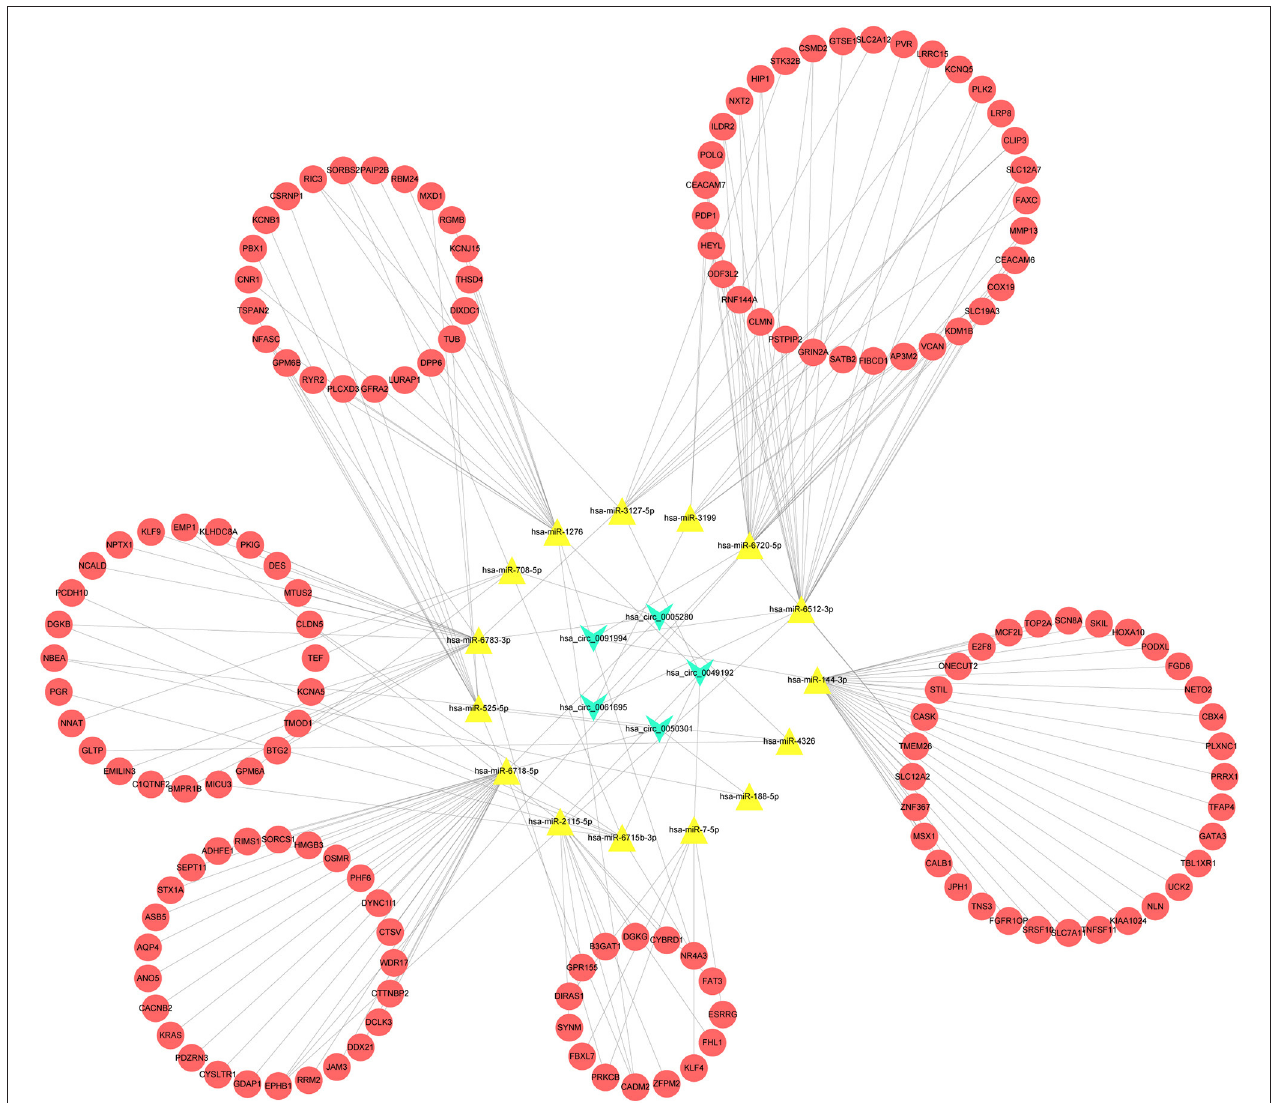
FIGURE 3 | A competing endogenous RNA (CeRNA) regulation network constructed by the circRNAs, 15 miRNAs, and 151 target mRNAs.